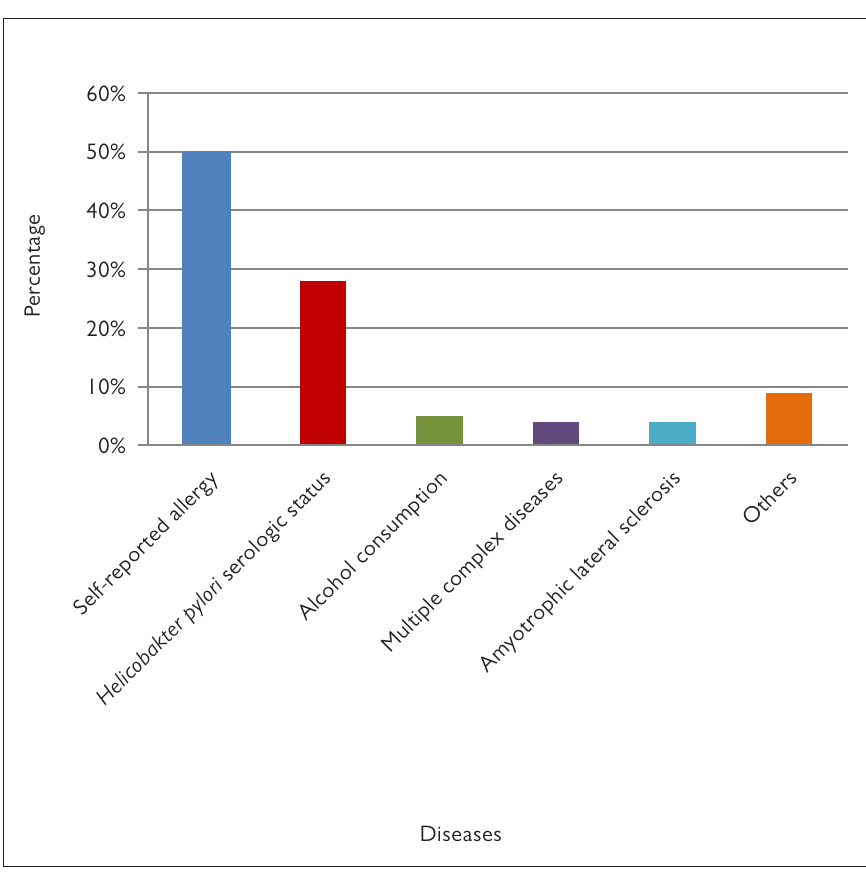
Figure 1. Illustration of the statistical calculation of the most common diseases or traits that might have been caused by archaic-like SNPs. The horizontal axis represents the most common diseases or traits and the vertical axis illustrates the frequency of the disease. Self-reported allergy is the most seen disease followed by Helicobacter pylori infection . Interestingly, alcohol consumption and amyotrophic lateral sclerosis had an association with archaic-like SNPs (5% and 4%, respectively). Other traits that were found <1% are endometriosis, blood pressure, coronary artery disease, abnormal lymphocyte counts, Paget’s disease, height, allergic sensitization, breast cancer, and suicide attempts in bipolar and panic